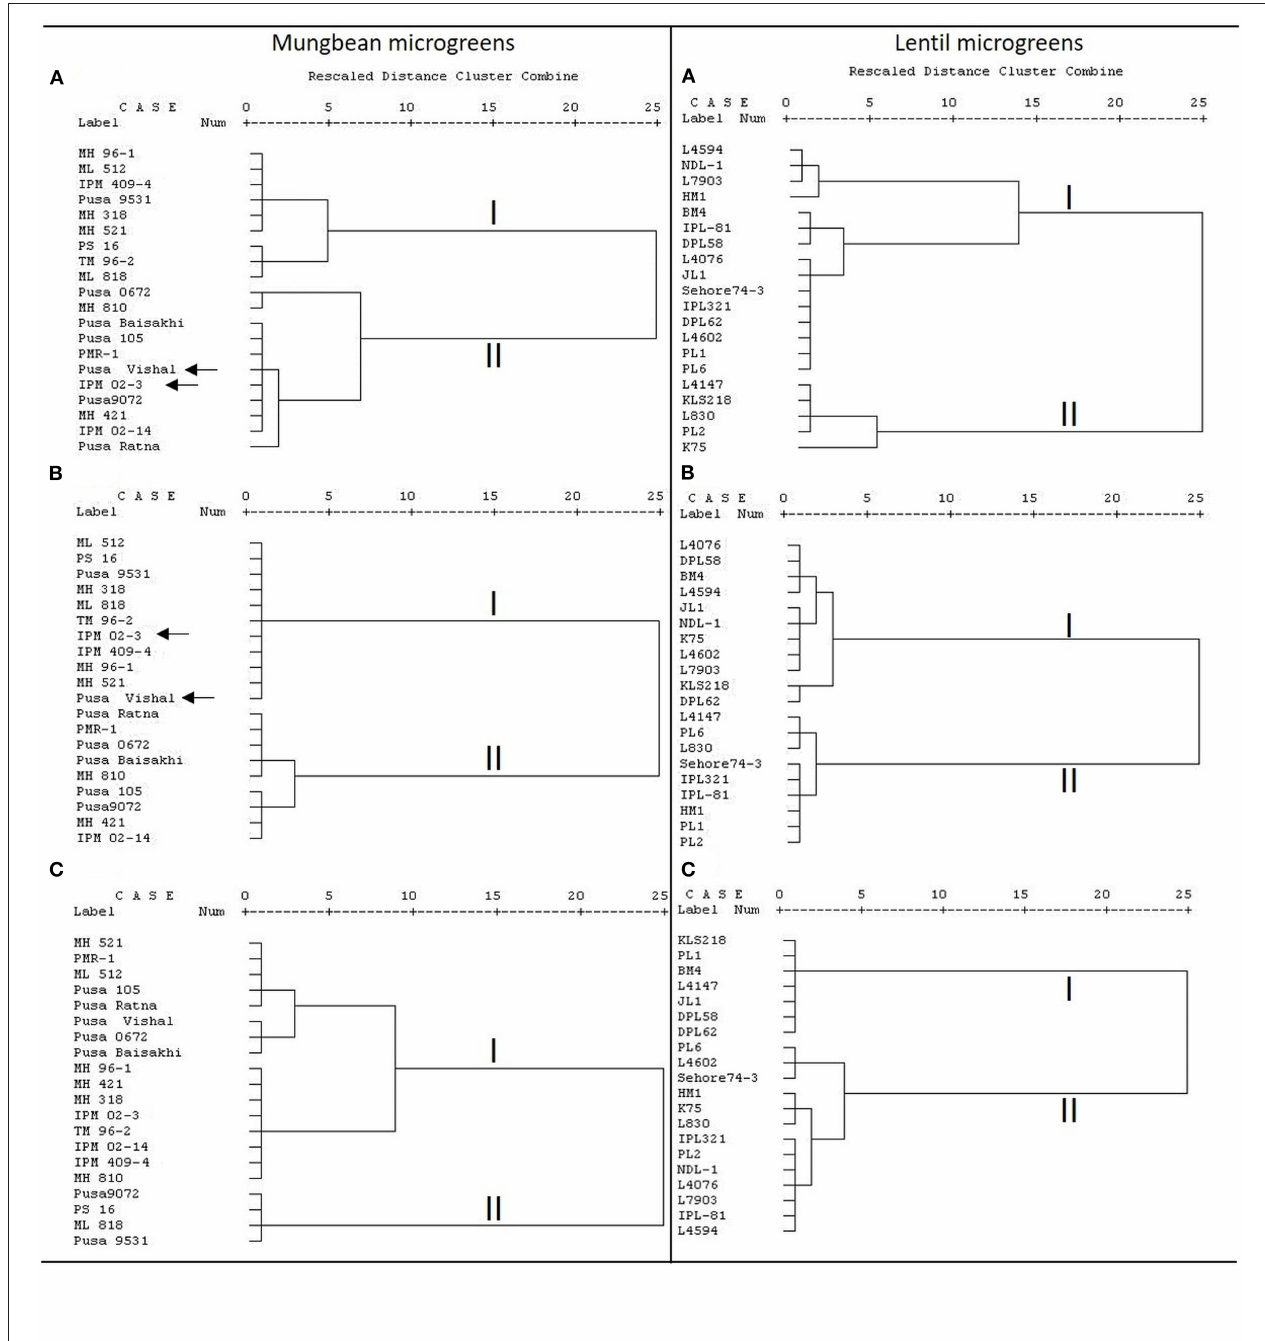
FIGURE 2 | Cluster analysis based on (A) total AoA as measured by DPPH, ferric-reducing antioxidant power (FRAP), and peroxide assay; (B) total phenolics content (TPC); (C) total flavonoids content (TFC) in mungbean and lentil microgreens, where dendrogram was prepared using the Ward method. lights were applied over normal light conditions ( Kyriacou et al., microgreens (Ca: 32–58; K: 217–369; Mg: 25–38; P: 63–88; Na: 31–42 mg/100 g FW). Interestingly, Ca and Mg were recorded 2019). more in lettuce microgreens over mature lettuce leaves (El- For micronutrients, the Delhi-grown mungbean microgreens Nakhel et al., 2020). Also, an increase in K and Na content showed significantly less Fe (0.4–0.59 mg/100 g FW) and Zn was recorded in various microgreens species like amaranth, cress, mizuna, and purslane when monochromatic red and blue